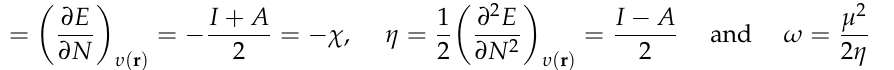
Table 2. Reactivity index of DADB and DEADP compounds.